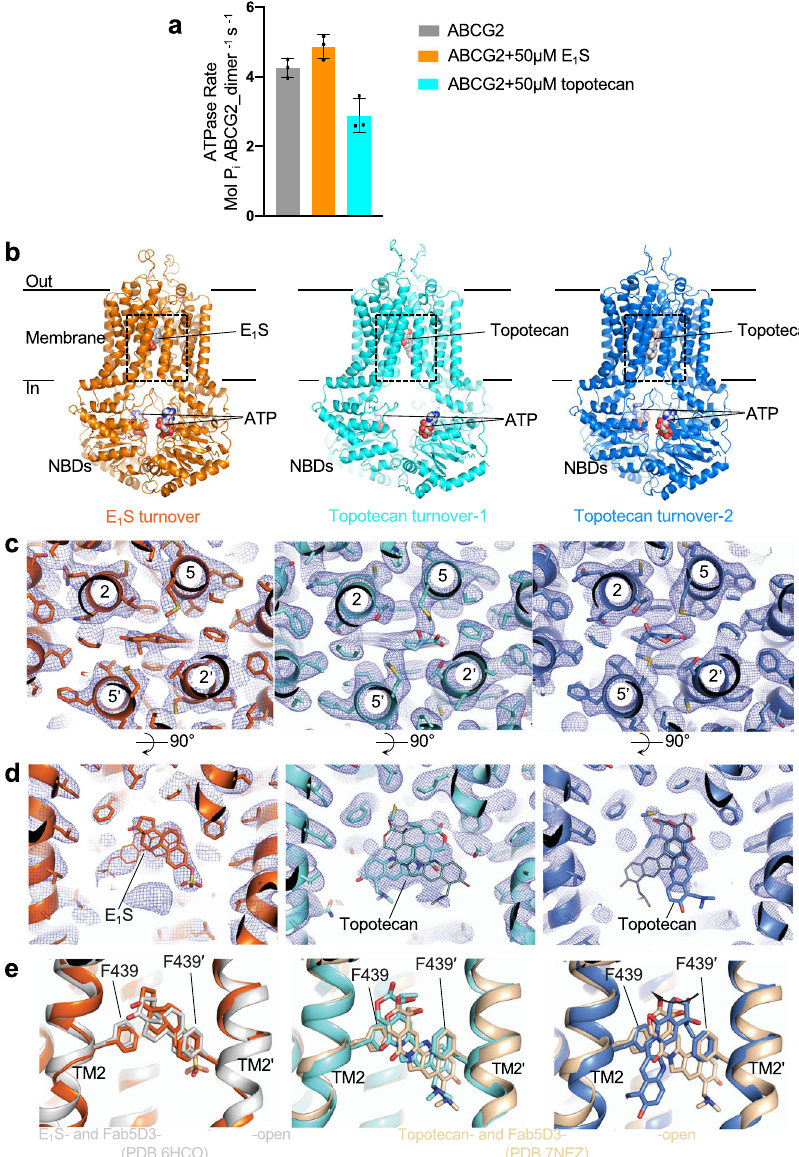
Fig. 1 Structures of ABCG2 under turnover conditions. a ATPase activity of nanodiscs-reconstituted wild-type ABCG2 in the presence and absence of 50 μ M E 1 S or 50 μ M topotecan. The bars show means rate. The experiment was performed three times independently with the same batch of nanodiscs ( n = 3); error bars depict standard deviations (s.d.) Source data are provided as a Source Data fi le. b Ribbon diagrams of turnover structures. E 1 S turnover is shown in orange, topotecan turnover-1 is shown in light cyan and topotecan turnover-2 is shown in blue. The coloring of the three structures is maintained throughout the fi gures and panels. Bound ATP, E 1 S, and topotecan are shown in sphere representation and labeled. c Close-up view of substrate-binding pockets between the TMDs viewed from the extracellular side. TM helices are shown as ribbons and labeled, residues and bound substrates are shown as sticks. Substrates are at center of the panels. Non-symmetrized EM density maps are shown as blue mesh. d Similar to c , but viewed from within the membrane. Bound substrates are labeled. Two possible orientations of bound substrates are shown for each density as thin or thick sticks, respectively. e Superposition of turnover states with structures of substrate-bound inward-open ABCG2 bound to 5D3-Fab fragments using the side chains of F439s as anchors. Left, E 1 S-bound ABCG2 structure (PDB 6HCO) is shown in gray cartoon. Middle and right, topotecan-bound ABCG2 structure (PDB 7NEZ) is shown in yellow cartoon. The substrates and side chains of F439 residues are shown as